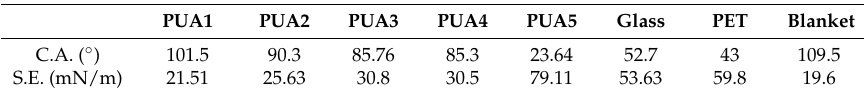
Table 1. Contact angles and surface energies of various resins used to fabricate clich é and other materials for